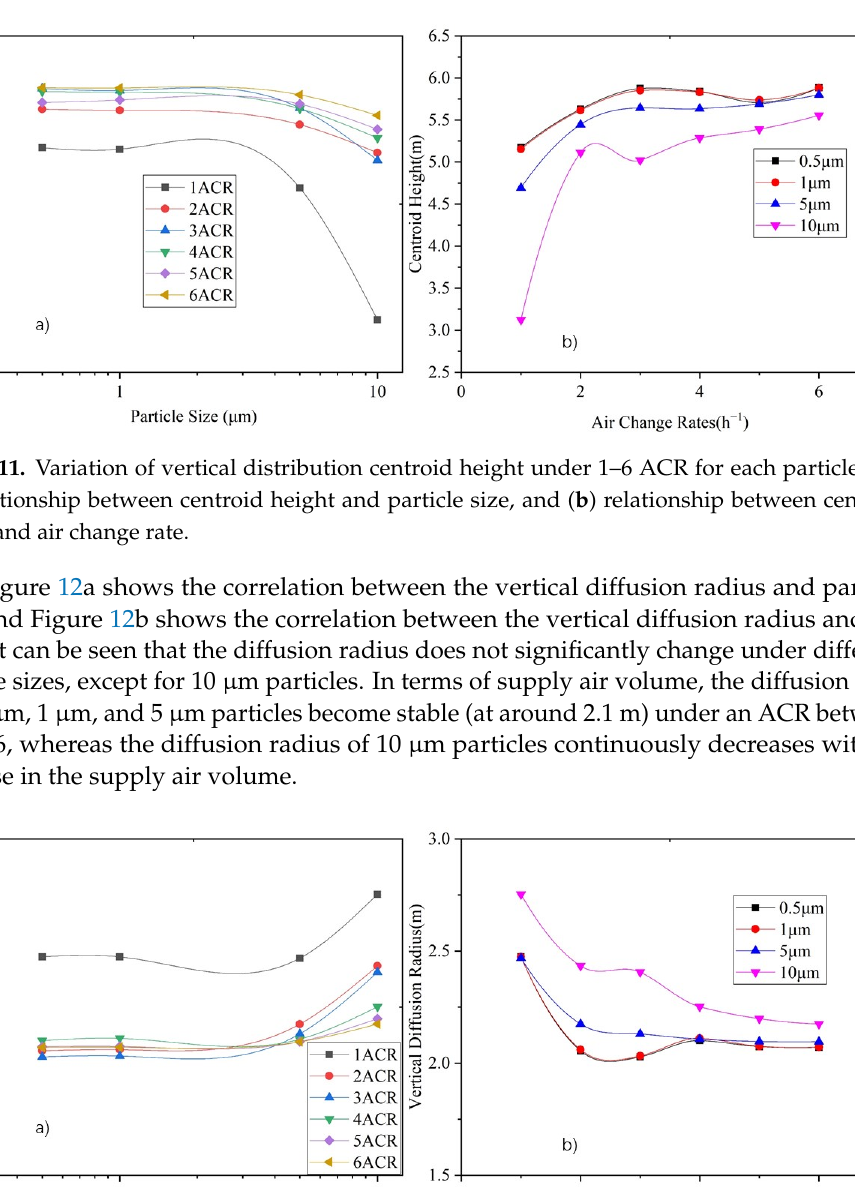
15 of 27 Figure 10. Relationship between the workspace inhomogeneity factor and air change rate. 3.3. Distribution Indices of Particle Concentration The vertical particle concentration distribution centroid, diffusion radius, and strati- fication height, calculated by Equations (10)–(12), respectively, can be used to indicate the vertical distribution characteristics of particles. Figure 11 shows the vertical particle con- centration distribution centroid of each particle size under various air supply volumes.